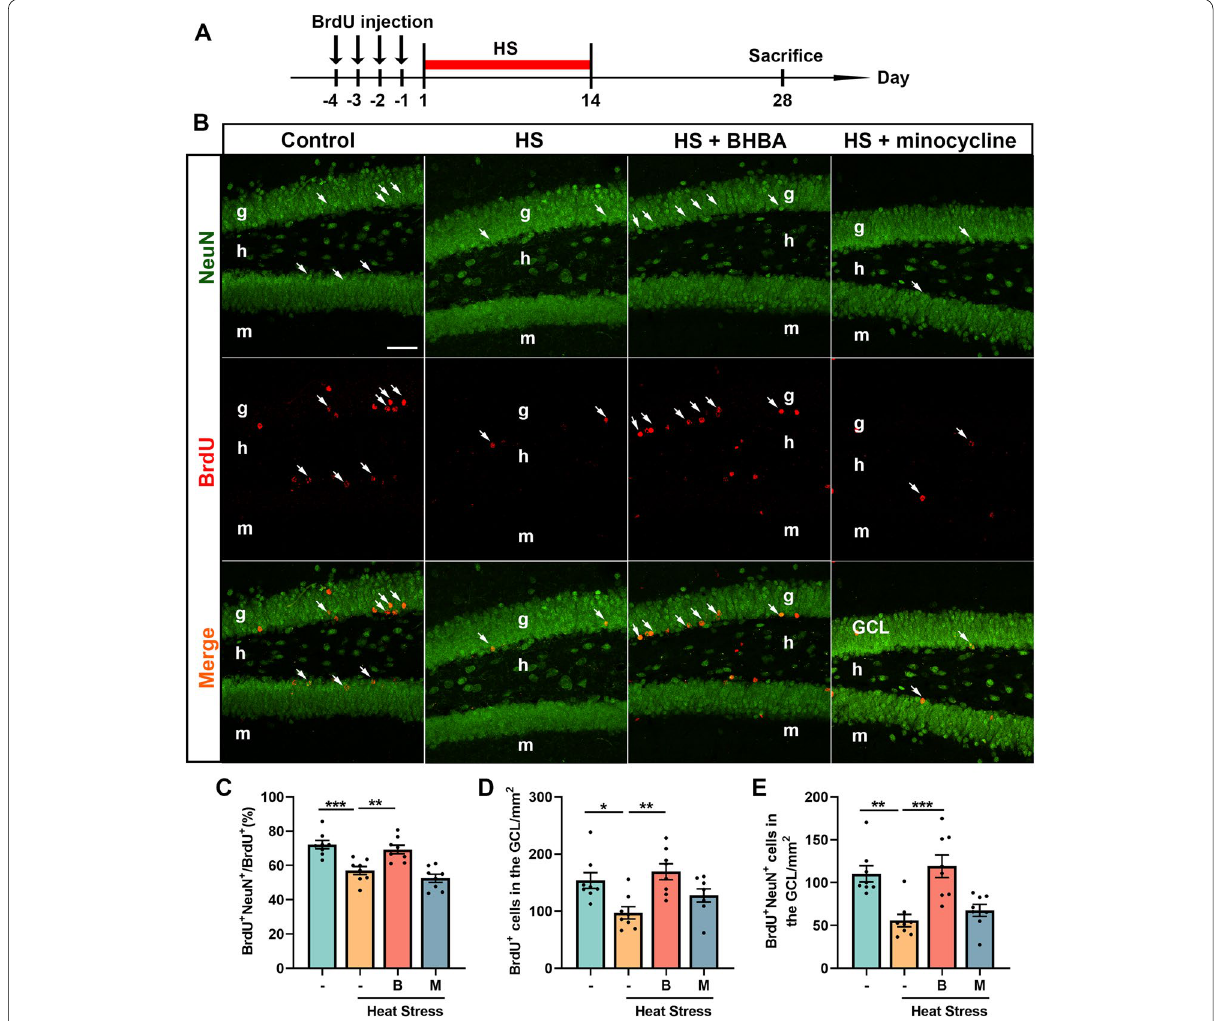
Fig. 4 BHBA increases the neuronal differentiation and survival in the heat stress-treated mice. A Timeline of the experimental procedure. B Immunofluorescent photomicrographs of BrdU (red) and NeuN (green) in the dentate gyrus. White arrows indicate BrdU + NeuN + newborn neurons in the GCL. C The ratio of BrdU + NeuN + cells to total BrdU + cells in the GCL. Heat stress treatment reduced the ratio of BrdU + NeuN + cells to total BrdU + cells, which was increased by BHBA treatment. D , E The number of BrdU + cells ( D ) and BrdU + NeuN + cells ( E ) in the hippocampal GCL. Heat stress-treated mice showed a reduced number of BrdU + and BrdU + NeuN + cells in the GCL. Administration with BHBA increased the number of BrdU + and BrdU + NeuN + cells in the heat stress-treated mice. Scale bars 40 μm. All data analyses were performed using one-way ANOVA with = Tukey’s post-test. Data are represented as mean SEM. C‑E n 8 from 4 mice. * p < 0.05, ** p < 0.01, *** p < 0.001. B, BHBA; g, granule cell layer; h, hilus; ± = HS, heat stress; m, molecular layer; M,